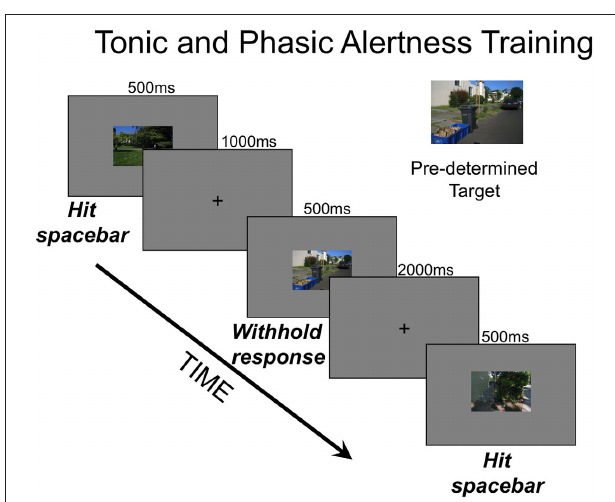
Figure 2 | TAPAT task. Each day, the training session began with the patients familiarizing themselves with a new target scene while reading the following instructions as the experimenter read them aloud: “You will see many scenes over the next 12 min. Your job is to hit the spacebar as fast as you can for each scene except when the scene is the target scene. When you see the target scene, do not hit the spacebar. The target scene for today is the following [Example Target Scene]. Please take a minute to memorize this scene.” Each 12-min round contained 360 trials: 36 target scenes (10%) and 324 non-target scenes (90%) randomly ordered. Each scene subtended a visual angle of 4 ° (vertical) × 6 ° (horizontal). On each trial, scenes were presented for 500 ms and between trials a blank screen with a fixation “ + ” at the center was shown for either 1000 ms (33.3% of trials), 1500 ms (33.3% of trials), or 2000 ms (33.3% of trials). After completion of a round of 360 trials, patients took a short break (approximately 2 min) before beginning the next 12-min round of 360 trials. Each day, patients performed three of these 12-min rounds for a total of 1080